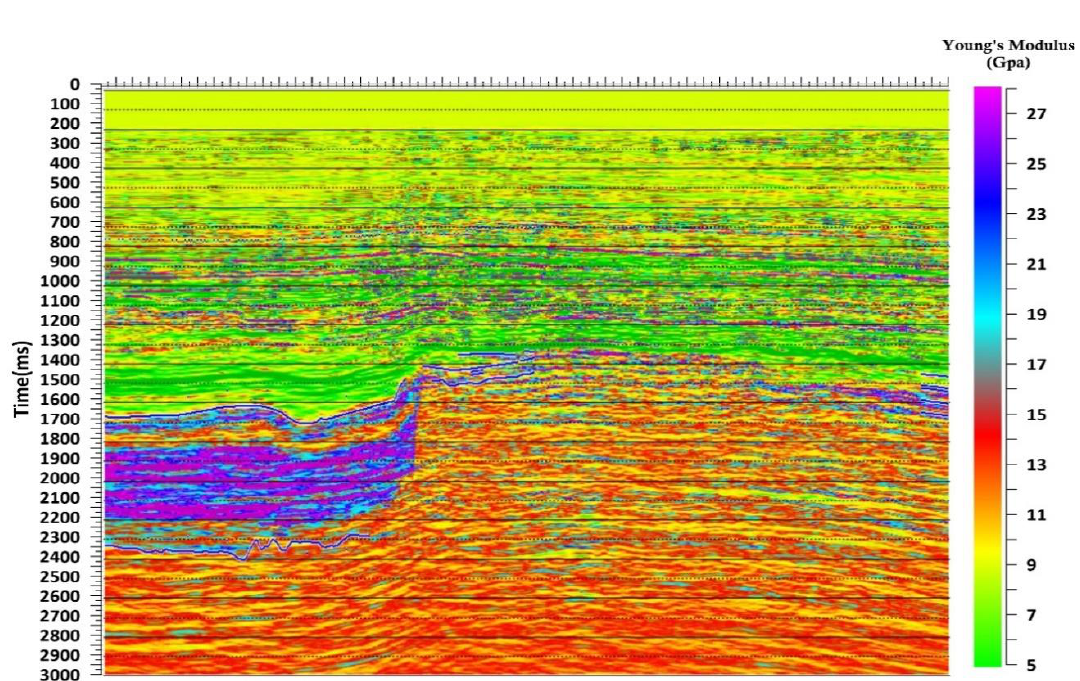
Figure 8. Young’s modulus of the subsurface of the North-Heera field calculated from the seismic inversion.